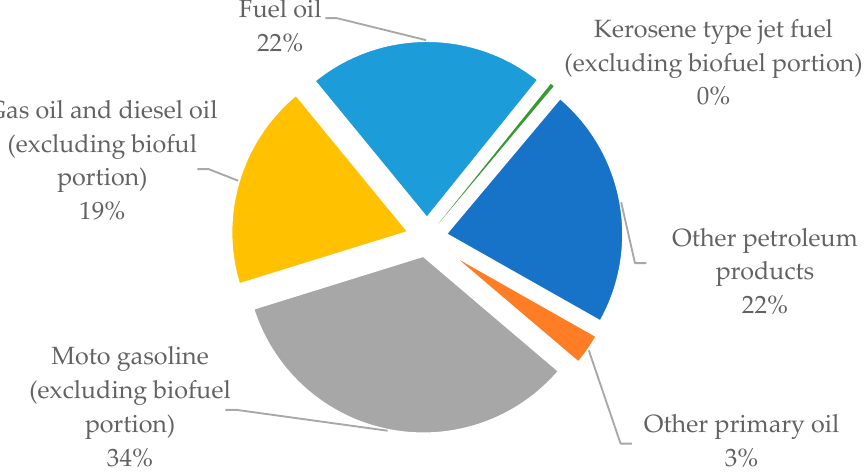
Figure 19. Fuels going into exports in Portuguese energy balance flow in 2019 (adopted from Eurostat data).